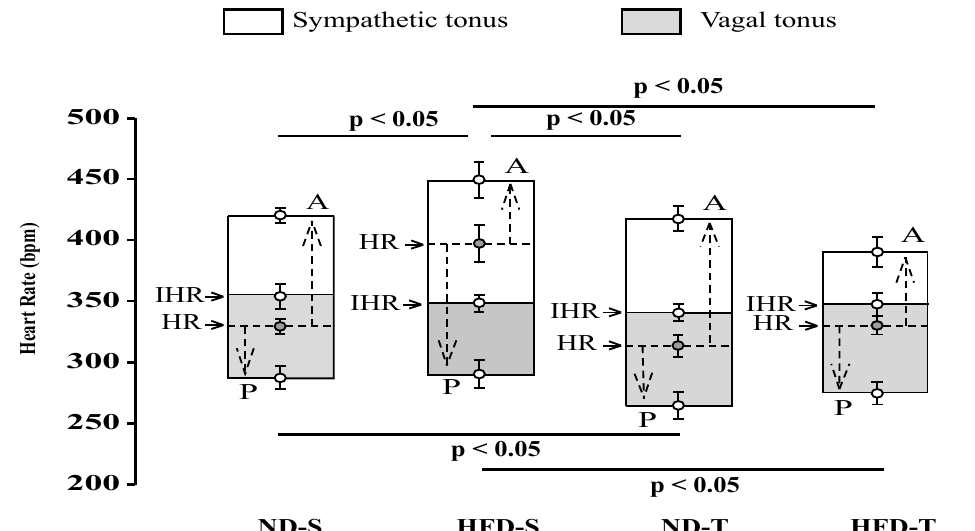
Figure 3. Bar graphs showing sympathetic (ST) and vagal (VT) tone, basal heart rate (HR), intrinsic HR (IHR) and changes (%) in HR (DHR) after atropine (A) and propranolol (P) injections in conscious Wistar rats that were divided in four treatment groups, respectively, sedentary normal diet (ND-S, n=8), sedentary high-fat diet (HFD-S, n=8), trained normal diet (ND-T, n=8) and trained high-fat diet (HFD-T, n=8). The VT was estimated by the difference between the IHR (double blockade by atropine and propranolol) and the maximal bradycardia achieved after sympathetic blockade with propranolol. The ST was evaluated by the difference between the IHR the highest tachycardia observed after vagal blockade with atropine. Data presented as mean ± SEM. (Statistical differences were determined by 2-way ANOVA followed by Tukey post-test).